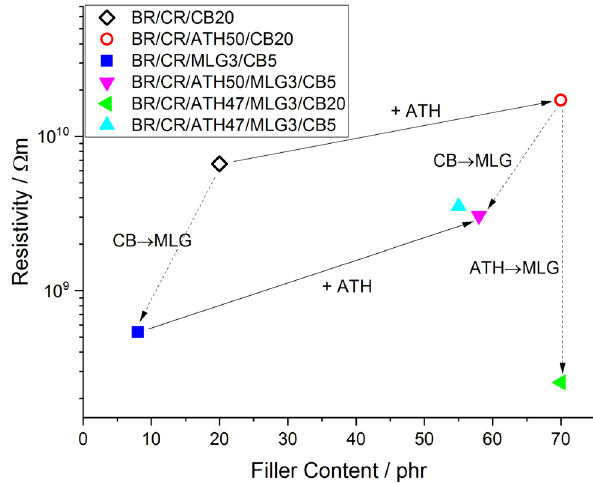
Figure 9: Electrical resistivity of BR/CR composites as a function of fi ller content. Solid line is addition of 50 phr ATH; dashed line is replacement of 15 phr CB with 3 phr MLG, or 3 phr ATH with 3 phr MLG, respectively.